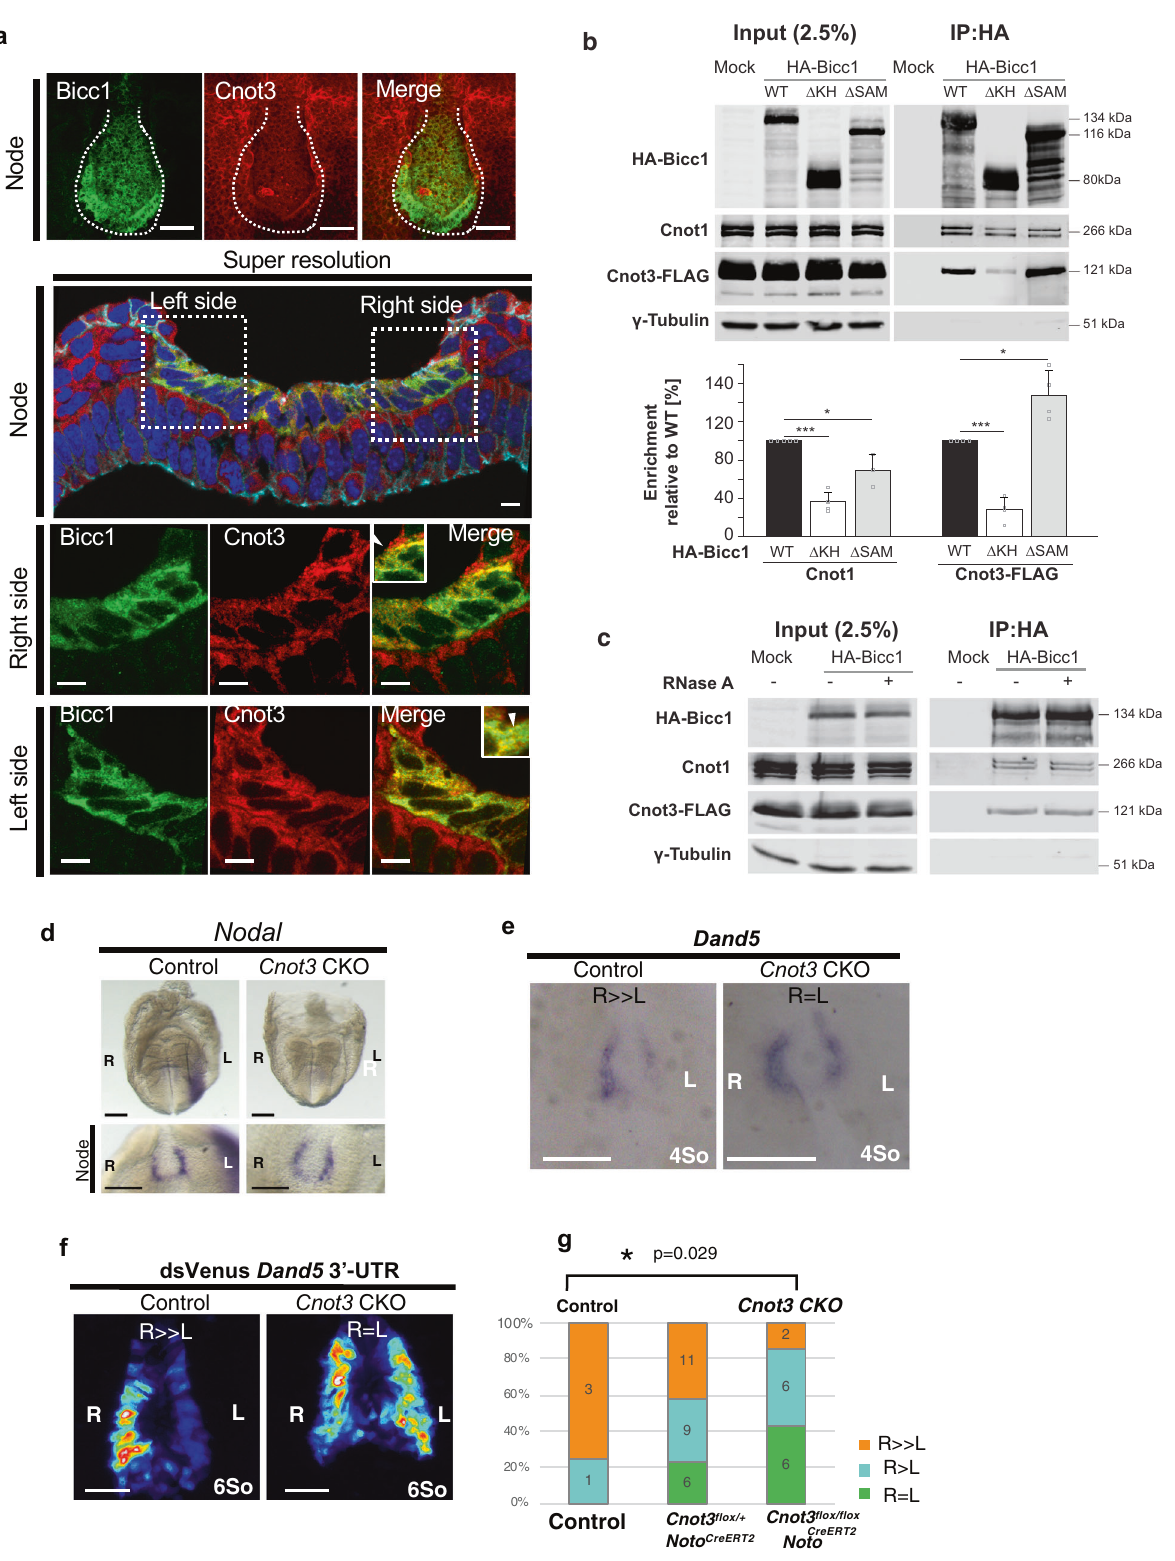
Transgenes containing only the proximal 200bp region (200prox) or a truncated 3 ′ -UTR lacking the proximal or distal 200 bp region (NDE-Hsp-dsVenus-3 ′ - UTR Δ 200prox or Δ 200dist) were generated analogously. Generation of transgenic and mutant mice . Dand5 Δ 200prox/ Δ 200prox embryos (Fig. S1) and Bicc1 Δ ex1/ Δ ex1 embryos (Fig. S2) were generated with the use of the